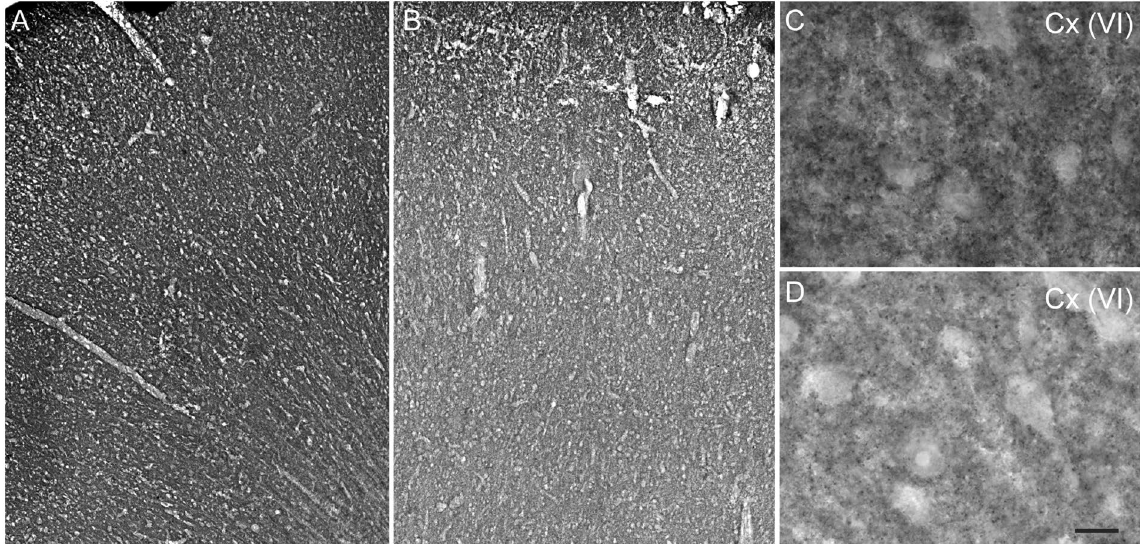
Figure 5. Immunohistochemical detection of VGLUT1 in BA9. Sections from the prefrontal cortex of a control ( A , C ) and of a matched patient ( B , D ) with severe dementia were immunostained for VGLUT1. Photomicrographs were taken of the entire BA9 layer ( A , B ) or at the level of layer VI (Cx(VI) for C , D ). The scale bar in ( D ) represents 150 µ m in ( A , B ) and 25 µ m in ( C , D ).